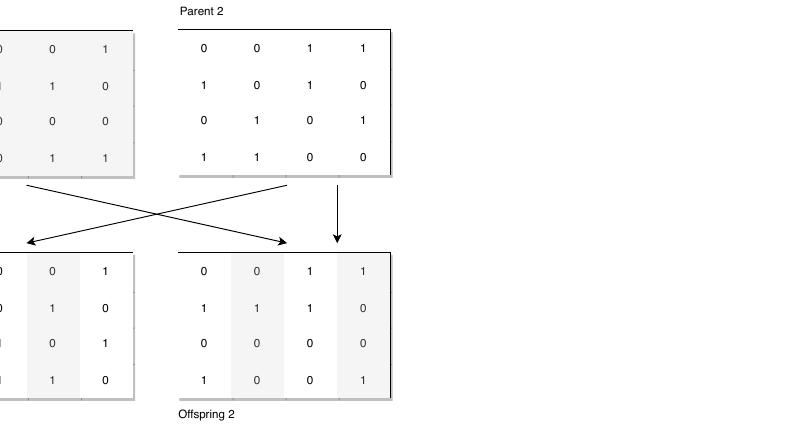
Figure 1. Graphical representation of the proposed crossover for the ISHOP with item units.